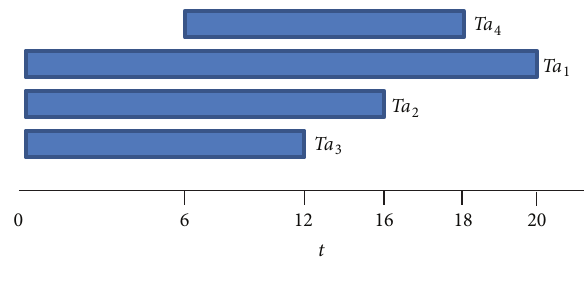
Figure 2: Multitask performance